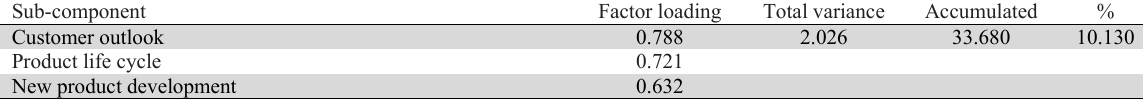
The summary of the sub-component influencing on details of content marketing Sub-component Factor